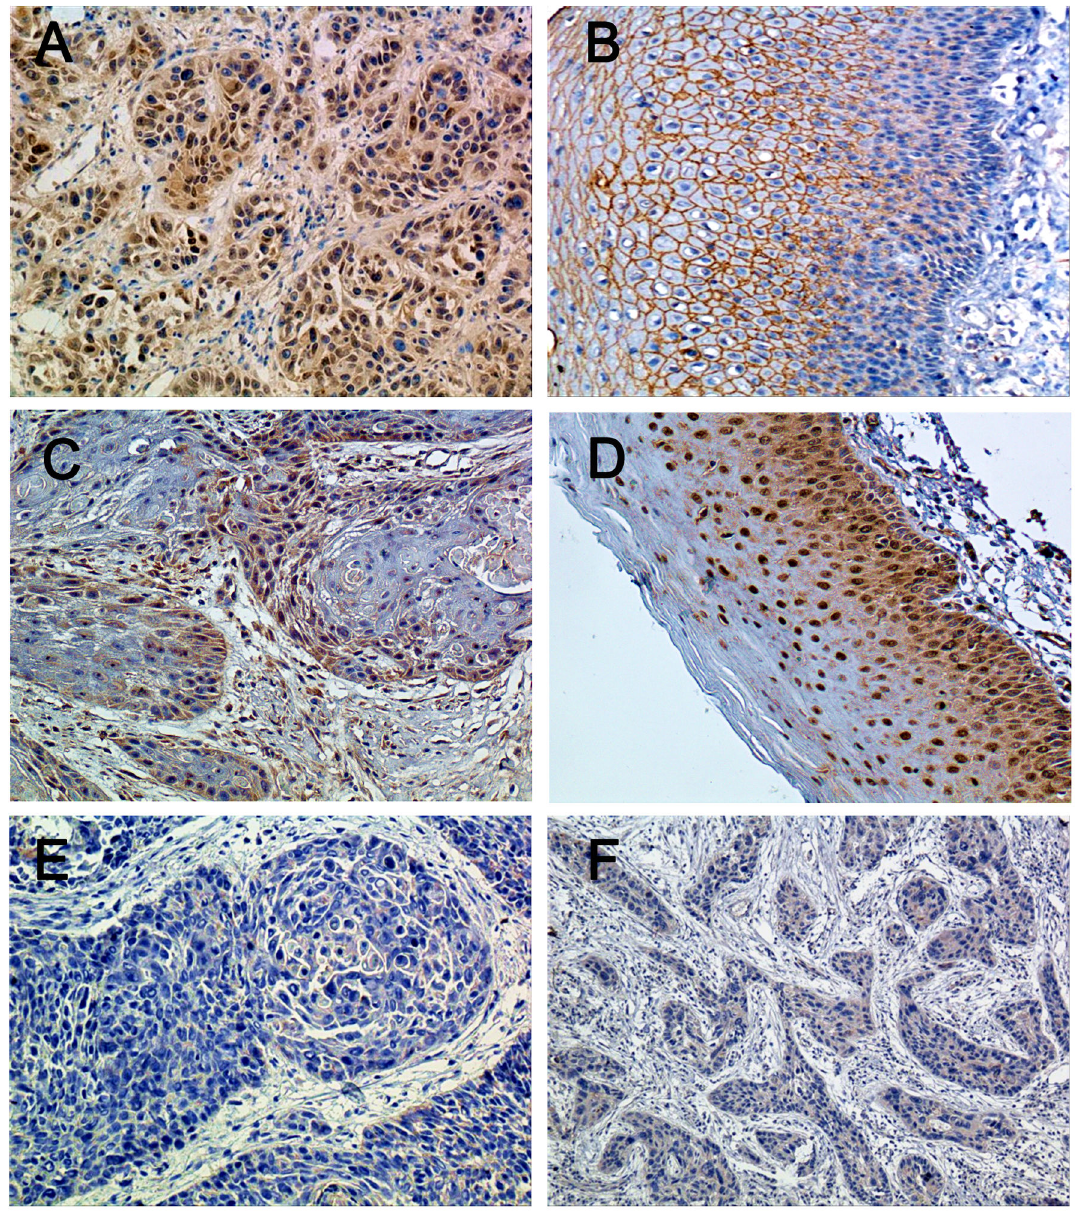
Figure 1. Representative images of beclin-1 and LC3 immunohistochemical